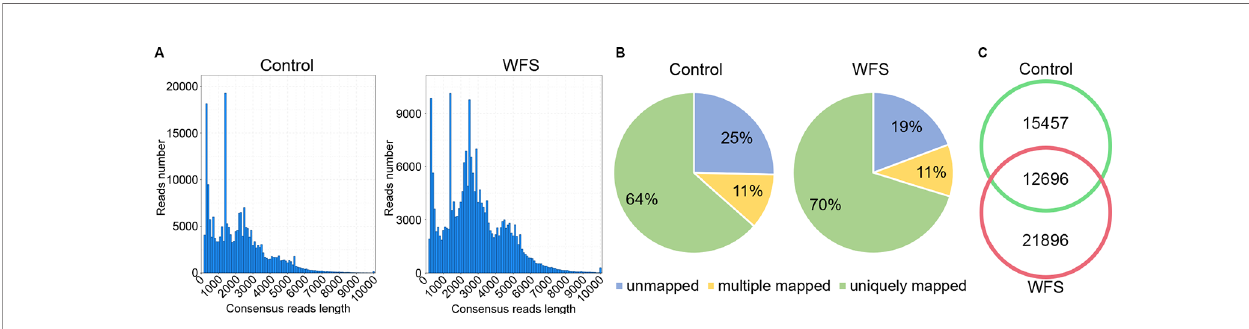
FIGURE 2 | Sequencing information of full-length transcriptome. (A) The length distribution of consensus reads in Control and white feces syndrome (WFS). (B) The consensus reads were aligned to the shrimp reference genome. More than 75% reads have been mapped to the shrimp genome. (C) Veen diagram showed the overlap of detected transcripts between Control and WFS.